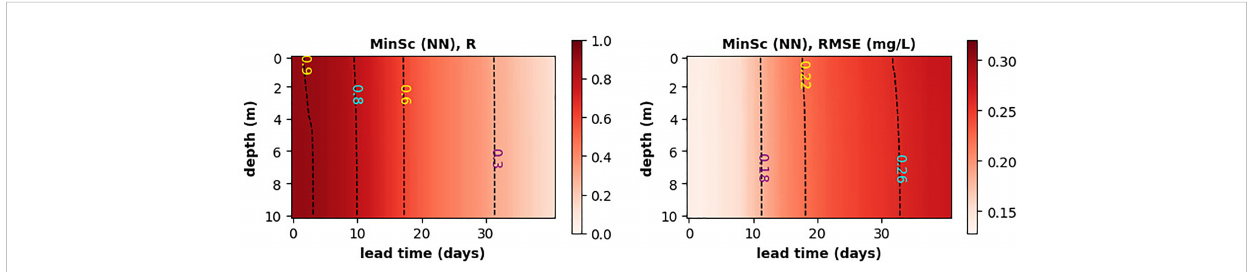
FIGURE 6 The skill of MLP NN model, measured by the Pearson correlation (left panel) and RMSE (right panel), to forecast oxygen anomaly across the full water-column at the GB location. The neural network uses as inputs only